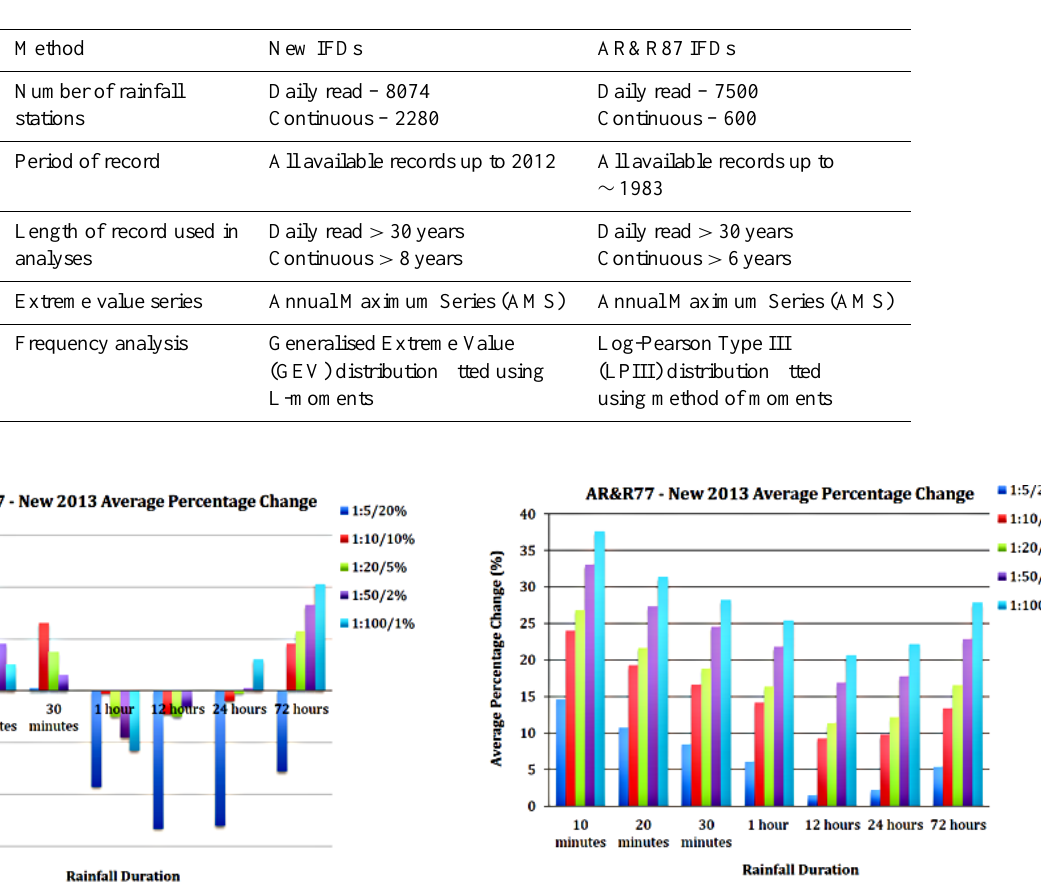
Table 2. Differing methodologies for AR&R87 and the new 2013 IFDs.